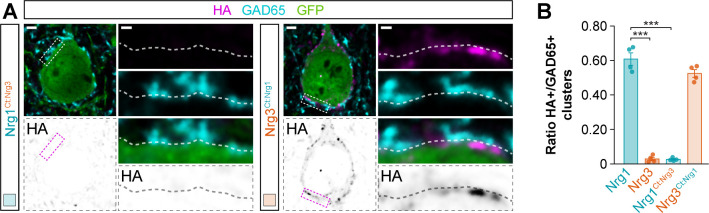
Synaptic targeting of C-terminal domain-swapping neuregulin constructs to inhibitory postsynaptic clusters in the somatic compartment of cortical pyramidal cells.(A) Co-localization of HA-tagged chimeric Nrg1Ct:Nrg3 (left) and HA-tagged chimeric Nrg3Ct:Nrg1 (right) (magenta) with soma-targeting GAD65+ boutons (cyan) in electroporated GFP+ pyramidal cells (green). The bottom panel depicts HA staining in a color-inverted image. The high-magnification images illustrate the localization of HA-tagged neuregulins contacted by presynaptic GAD65+ boutons. (B) Quantification of the proportion of GAD65+ boutons that co-localize with HA-tagged Nrg clusters in the soma of electroporated GFP+ pyramidal cells. Tukey’s range test for post hoc comparison between wild-type Nrg1 construct and chimeric Nrg constructs: ***p<0.001, n = 4 mice (32 cells) for pSyn-Nrg1Ct:Nrg3-pSyn-Gfp; p=0.077, n = 4 mice (34 cells) for pSyn-Nrg3Ct:Nrg1-pSyn-Gfp; ***p<0.001, for comparison between chimeric Nrg constructs. Note that data for Nrg1 and Nrg3 wild-type constructs is the same data shown in Figure 3—figure supplement 3B. Scale bars, 2 μm (A) and 0.5 μm (high magnifications). Data in synaptic quantifications represent mean ± s.e.m. The averages per animal and electroporation condition are shown in bar graphs. Data used for quantitative analyses are available in Figure 5—figure supplement 3—source data 1.
Figure 5—figure supplement 3—source data 1.Numerical data of synaptic targeting of C-terminal domain chimeric neuregulin constructs in GFP+ electroporated pyramidal cells.